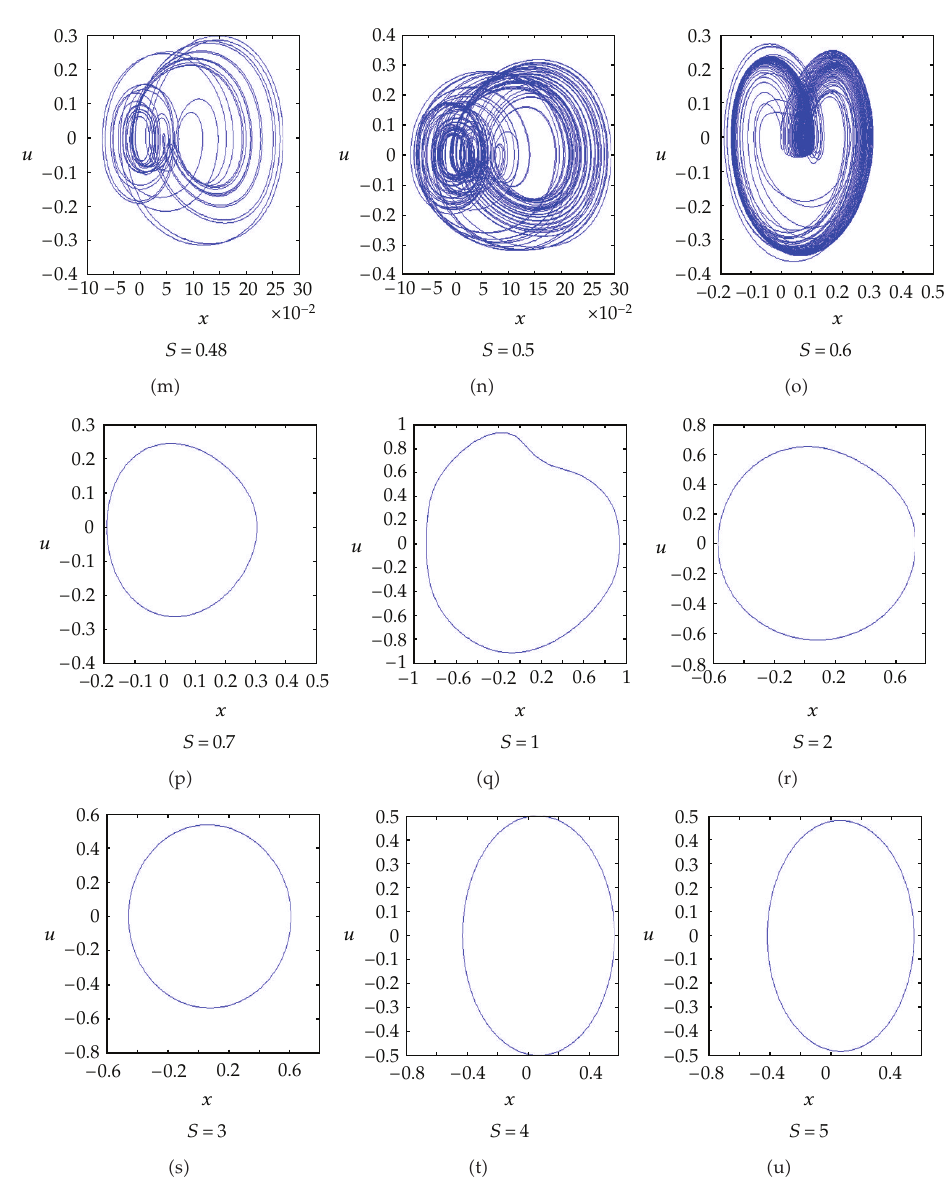
Figure 10: Phase diagrams for the route of subharmonic motion into chaos, out of chaos to periodic response at di ff erent rotating speed ratios of s (cid:2) with rub-impact e ff ect (cid:3)